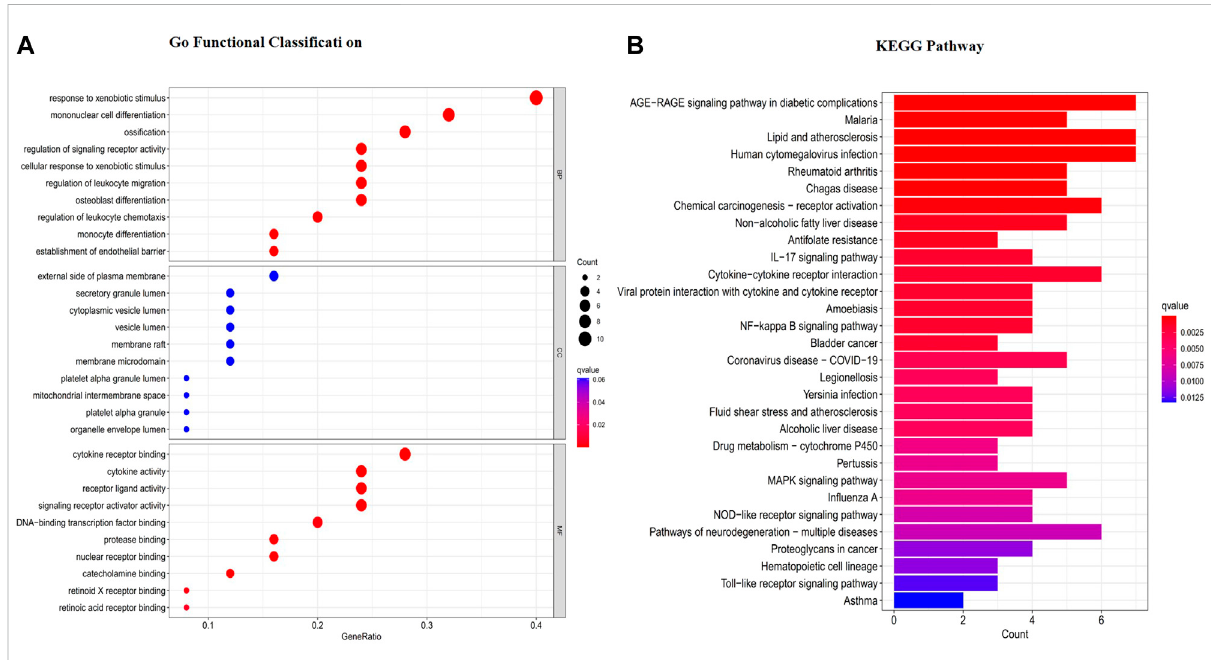
FIGURE 3 GO enrichment (A) and KEGG pathway analysis (B) of the HUA targets of the “ RG-ZJ ” herb